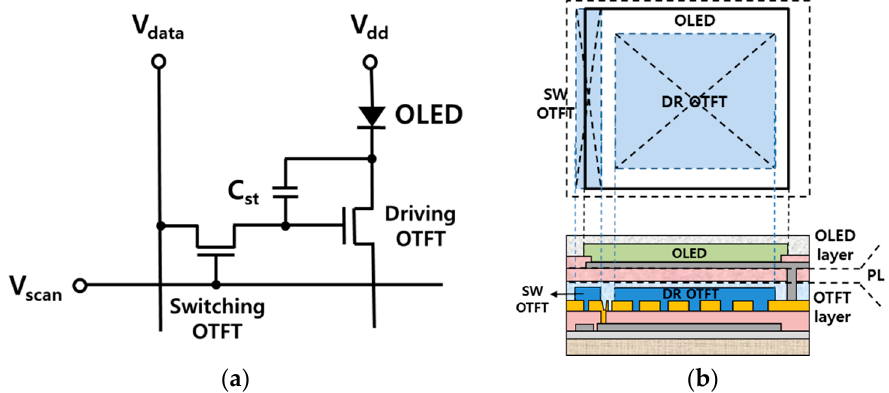
Figure 1. ( a ) The pixel circuit of the active-mode organic light-emitting diode (AMOLED) panel consisting of 2 organic thin-film transistors (OTFTs), 1 organic light-emitting diode (OLED), and 1 capacitor; and ( b ) the layout and cross-section of the stacked pixel.